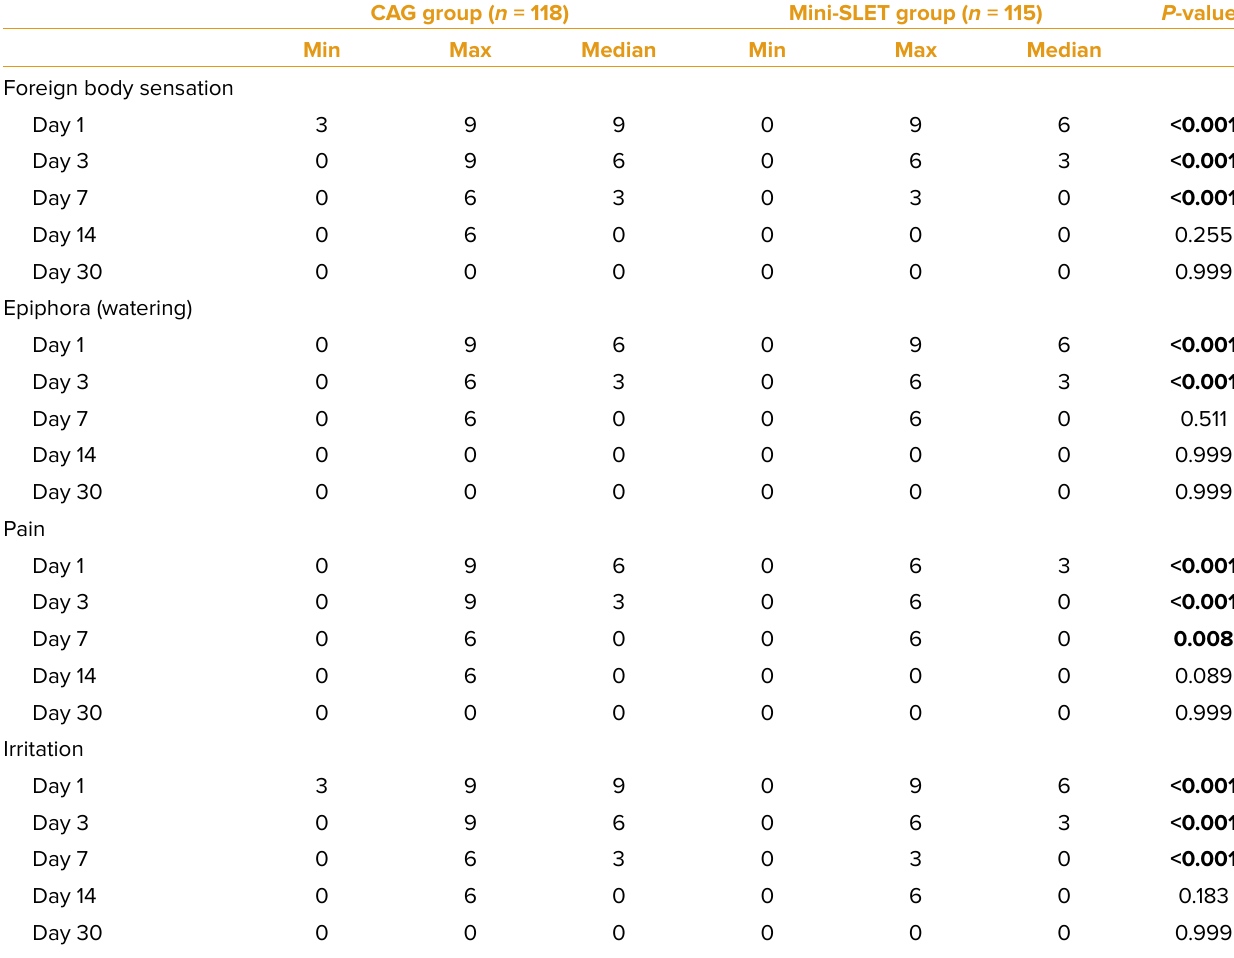
Table 3. Comparative outcome of the postoperative symptom score between the CAG group and mini-SLET group